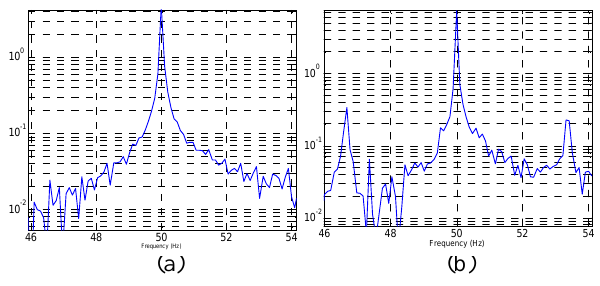
Fig. 2. FFT of the steady state current for: (a) unloaded machine with two broken bars (b) healthy machine with fluctuating load